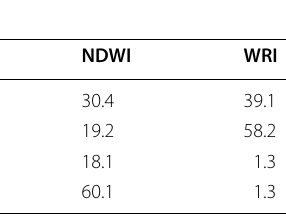
Table 6 Misclassified areas from indices based on the results from supervised classification Misclassified areas in